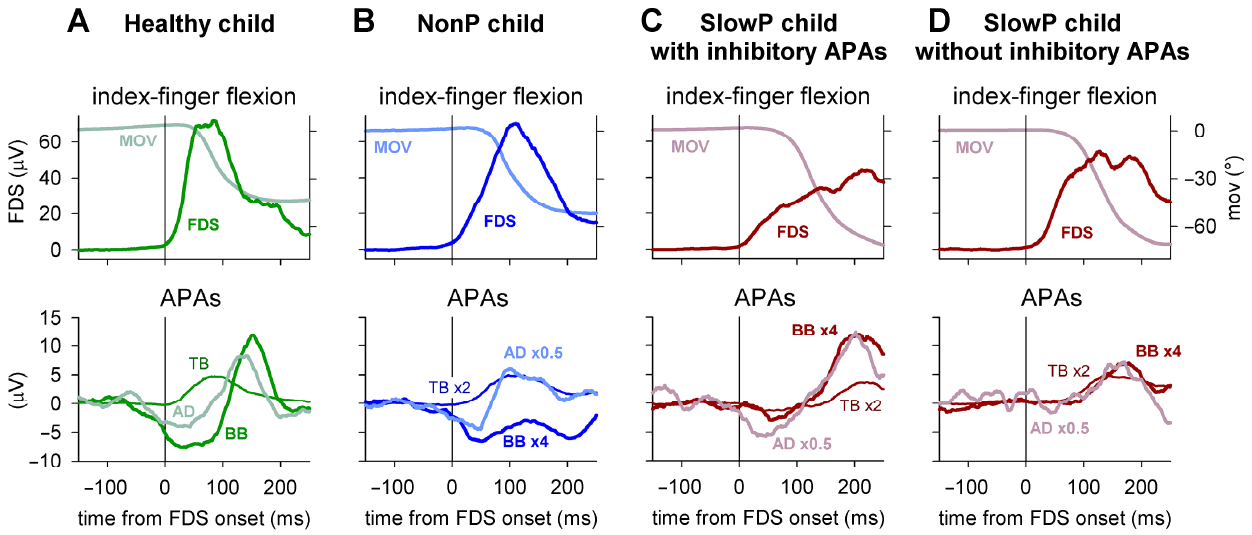
Figure 2. EMG and index finger kinematics obtained from four representative subjects. Averages of 45 movement trials, aligned to the onset of the prime moving muscle Flexor Digitorum Superficialis (FDS, solid vertical line). EMG was integrated for 40 ms. ( A ) One healthy child; the FDS onset was clearly preceded by inhibitory Anticipatory Postural Adjustments (APAs) in the Biceps Brachii (BB) and Anterior Deltoid (AD) and accompanied by an excitatory APA in the Triceps Brachii (TB). ( B ) One NonP child showing a behavior of recall comparable in pattern and timing to that of the healthy child. ( C , D ) Two SlowP children, one showing inhibitory APAs and one lacking them. Note that the APAs in TB were delayed in both SlowP children, which was also observed for the BB and AD APAs in the child in panel ( C ), while the APAs of the SlowP child shown in panel D were lacking, as if the delayed inhibition slipped under the following late excitation.